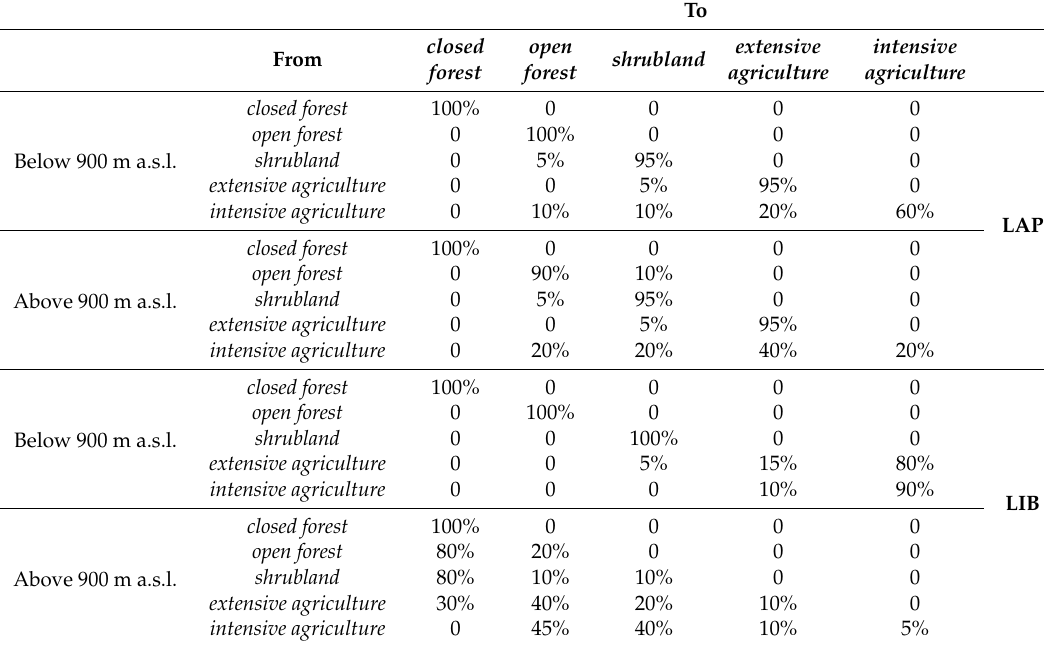
Table 3. Magnitude of change for each region scenario between 2009 and 2050: “liberalization” (LIB) and “lowered agriculture production” (LAP). Adapted from Bolliger et al. [13].